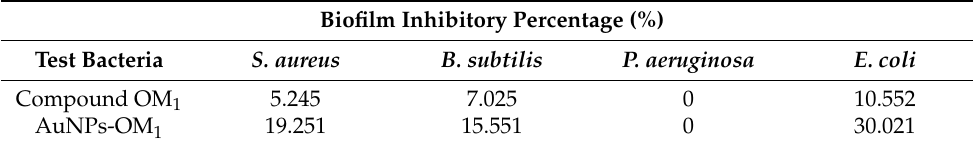
Table 3. Biofilm inhibitory percentage (%) of OM 1 and AgNPs-OM 1 .